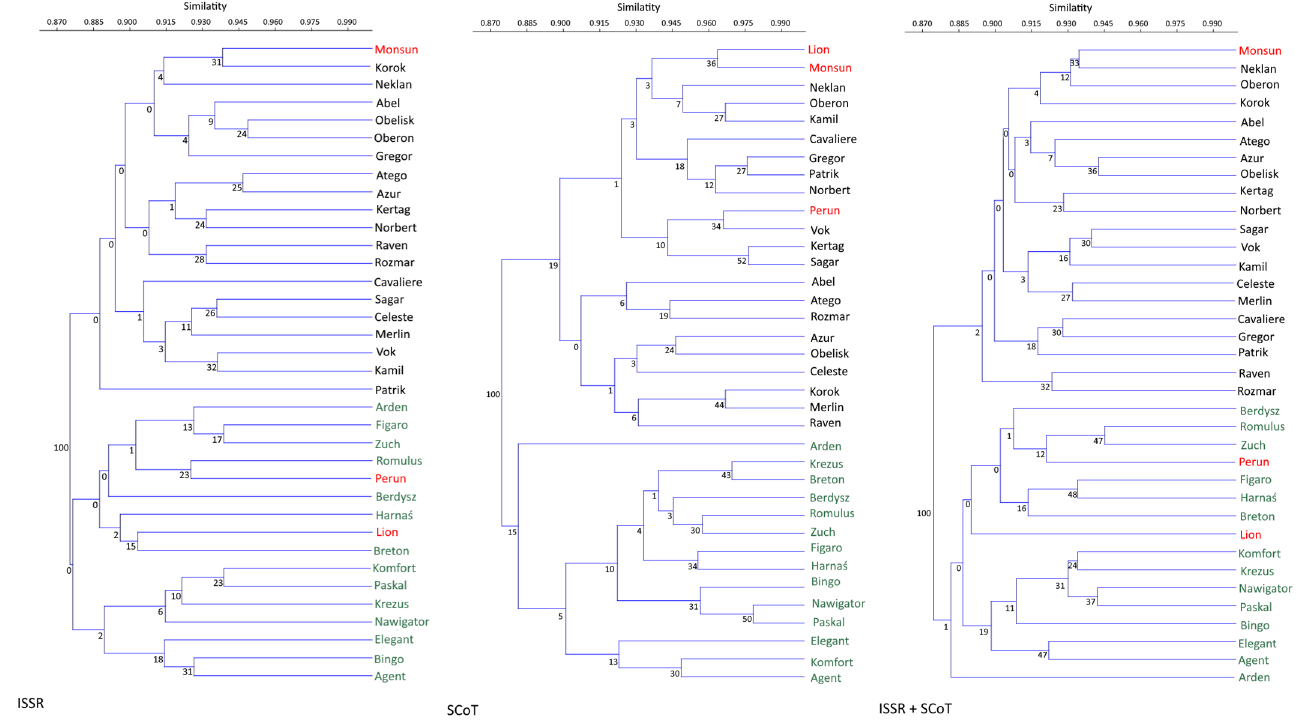
Figure 1. The UPGMA analysis of the 36 A. sativa L. cultivars. The origin of the analyzed varieties was marked with the following colors: green, Polish; black, Czech; red, German.